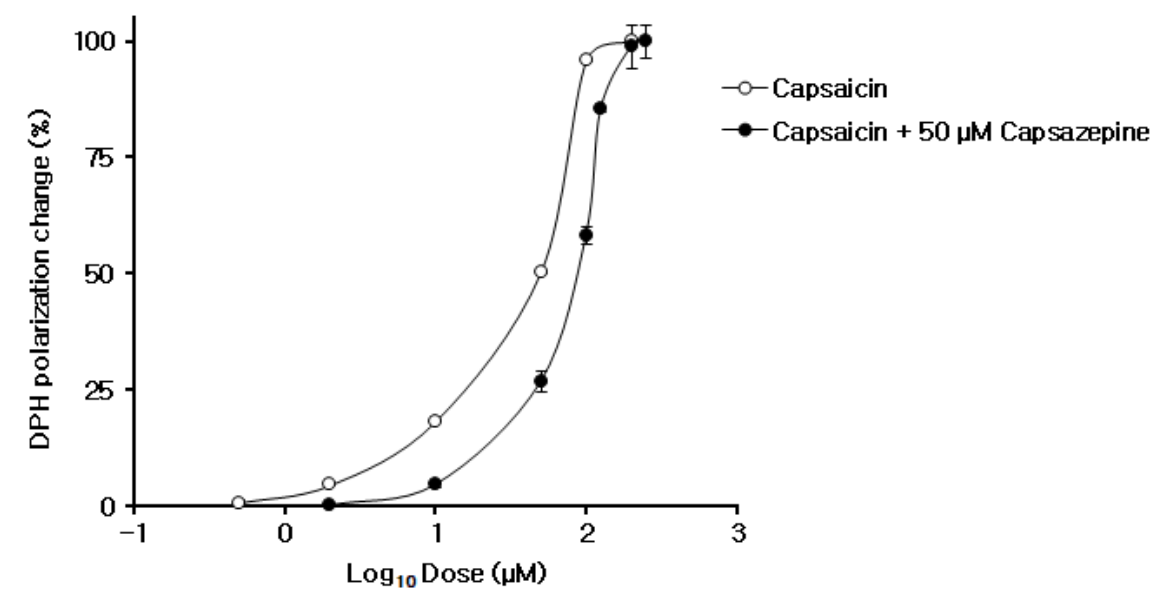
Figure 5. Effect of 50 µ M capsazepine on DPH polarization changes of neuro-mimetic membranes induced by capsaicin at 0.5–200 µ M. Doses (capsaicin concentrations) and responses (polarization changes) were plotted on the x- and y-axes, respectively, and the best-fit curve was plotted using the Hill equation. Open circles represent the changes by capsaicin in the absence of capsazepine and closed circles represent the changes by capsaicin in the presence of capsazepine. Each point represents mean ± SEM ( n = 5).